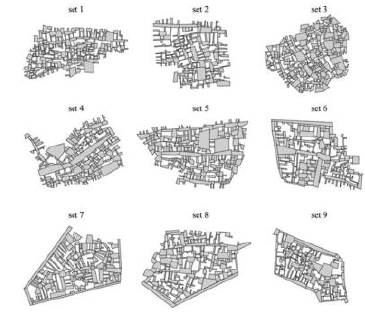
Figure 2. Covering of the Void Spaces of Nine Informal Settlements, Recife Region, Brazil (Sobreira & Gomes, 2001) They claimed that when there are no rigid boundaries (e.g. road,